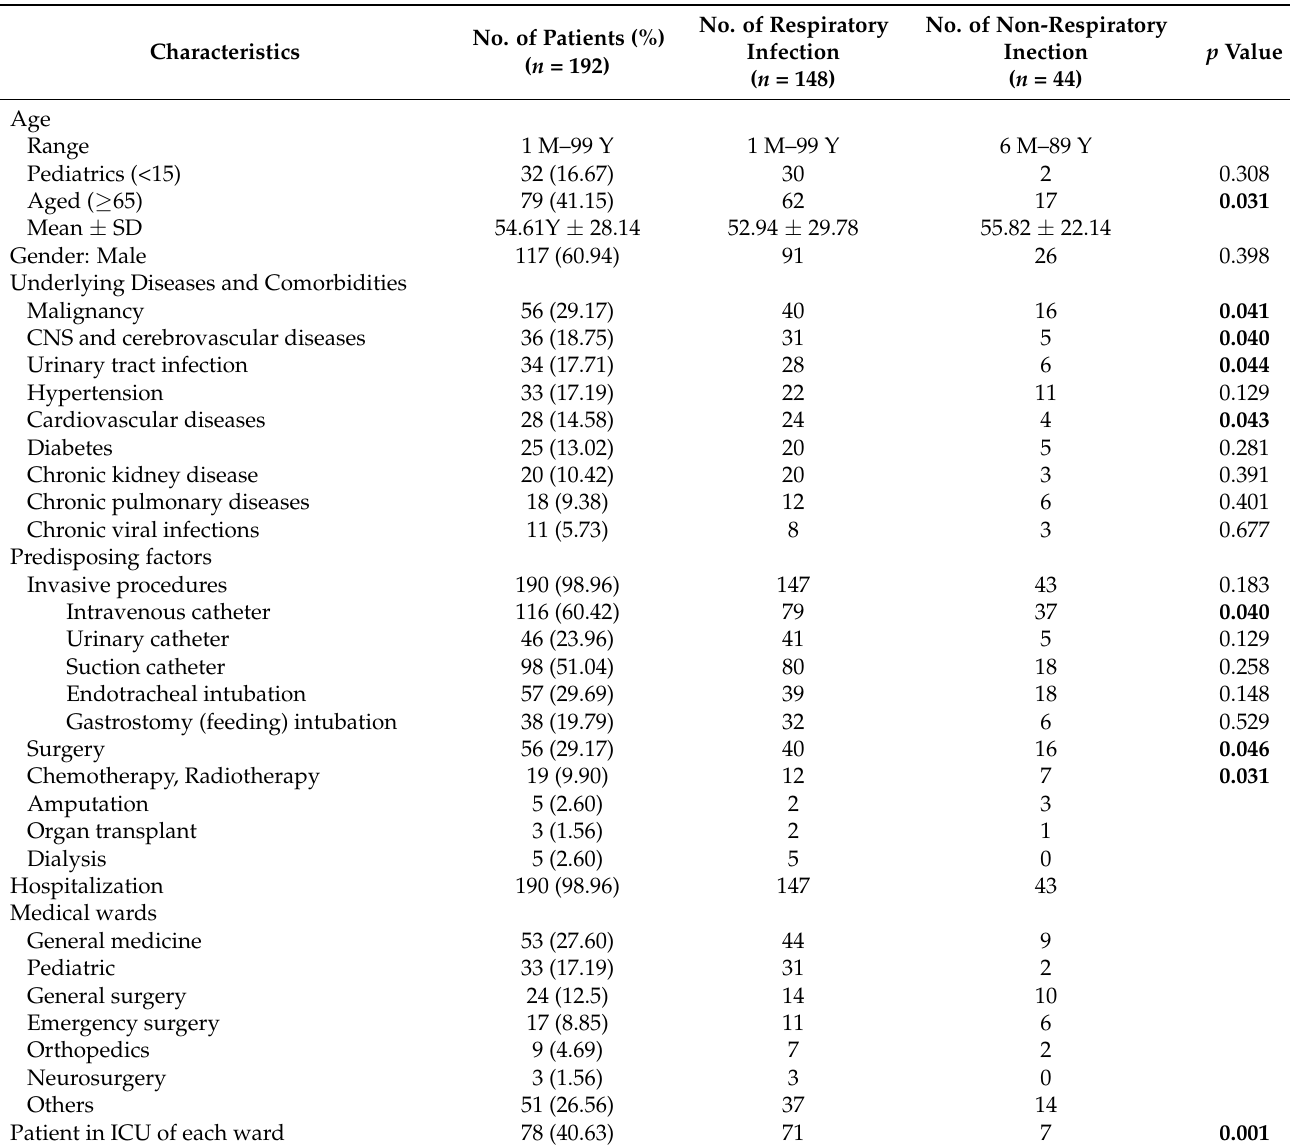
Table 1. Demographic and clinical characteristics, and risk factors of respiratory tract infections due to S. maltophilia